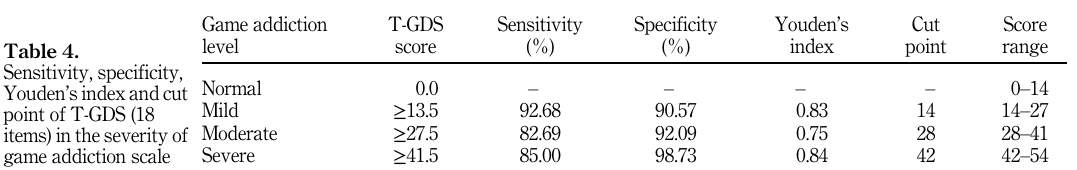
Table 4. Sensitivity, specificity, Youden ’ s indexandcut point of T-GDS (18 items) in the severity of game addiction